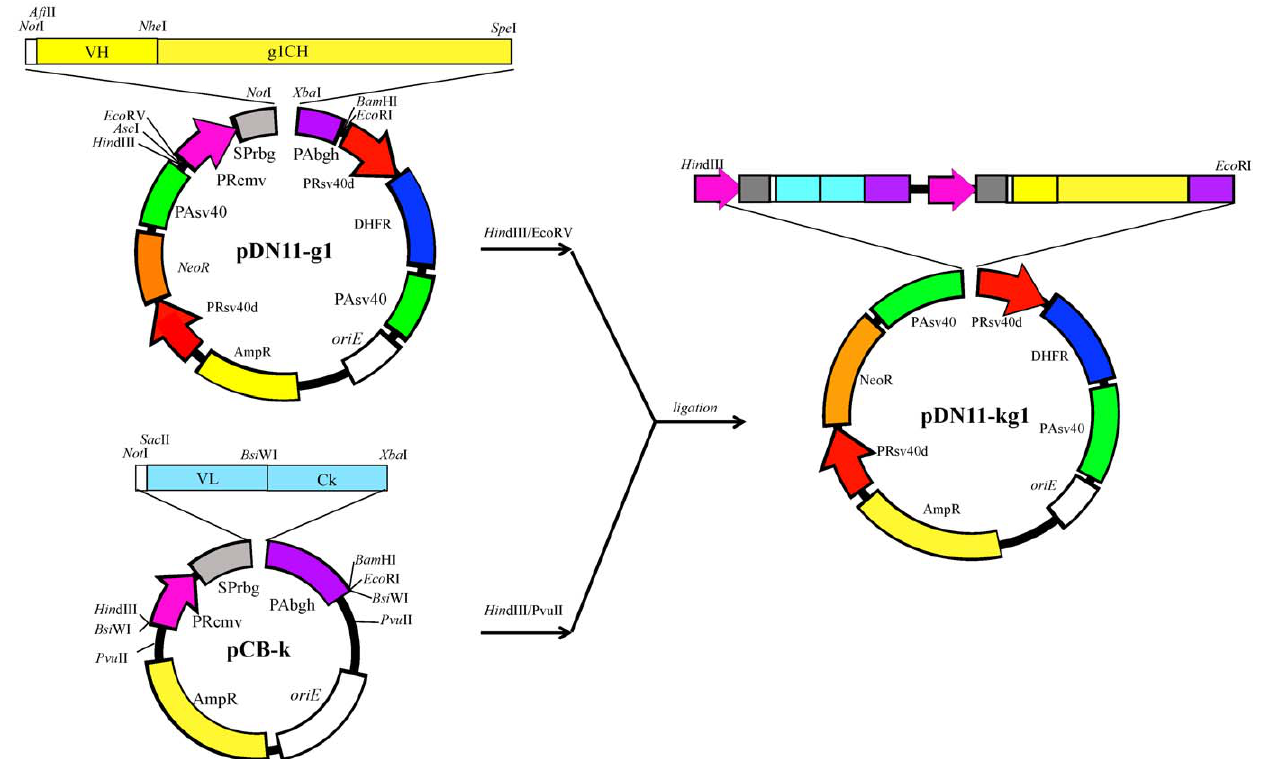
Figure 5. Scheme for the construction of pDN11-g1k. VH, heavy chain variable domain cDNA; VL, light chain variable domain cDNA; PAsv40, simian virus 40 terminator; PRcmv, cytomegalovirus promoter; g1CH, constant domain of human IgG1; Ck constant domain of human kappa chain; PRsv40d, enhancerless simian virus 40 promoter; NeoR, modified neomycin phosphotransferase gene; PAsv40, SV40 polyadenylation signal; PAbgh, bovine growth hormone gene terminator; SPrbg, rabbit beta-globin intron; AmpR, b -lactamase gene; DHFR, dihydrofolate reductase cDNA; oriE, replication origin of pBR322 plasmid.